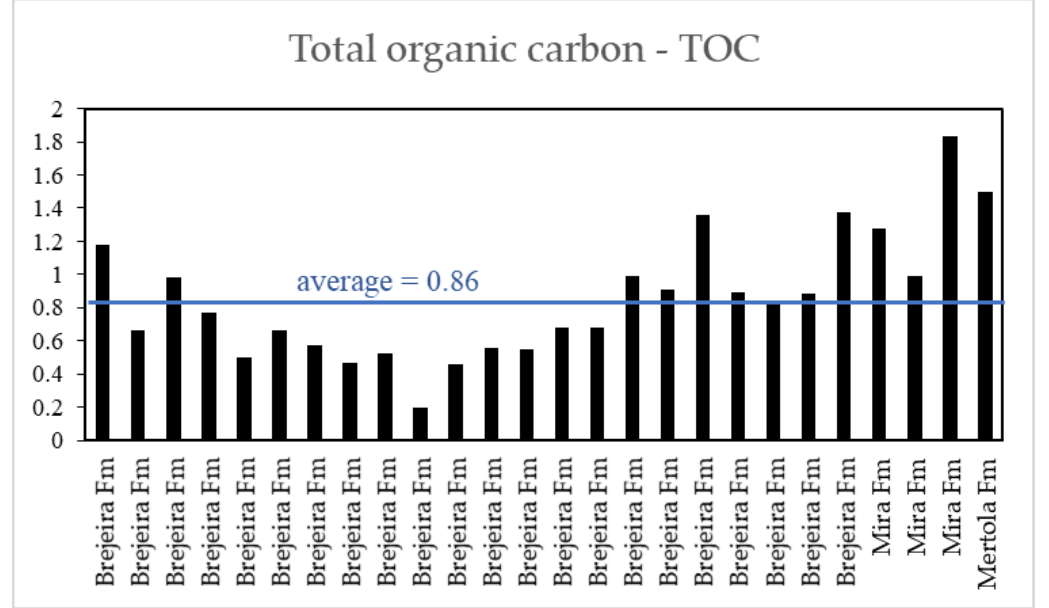
Figure 3. Distribution and average of TOC in the studied samples. For this graph, only samples also analyzed by Rock–Eval were taken in consideration. The blue line represents the average TOC.